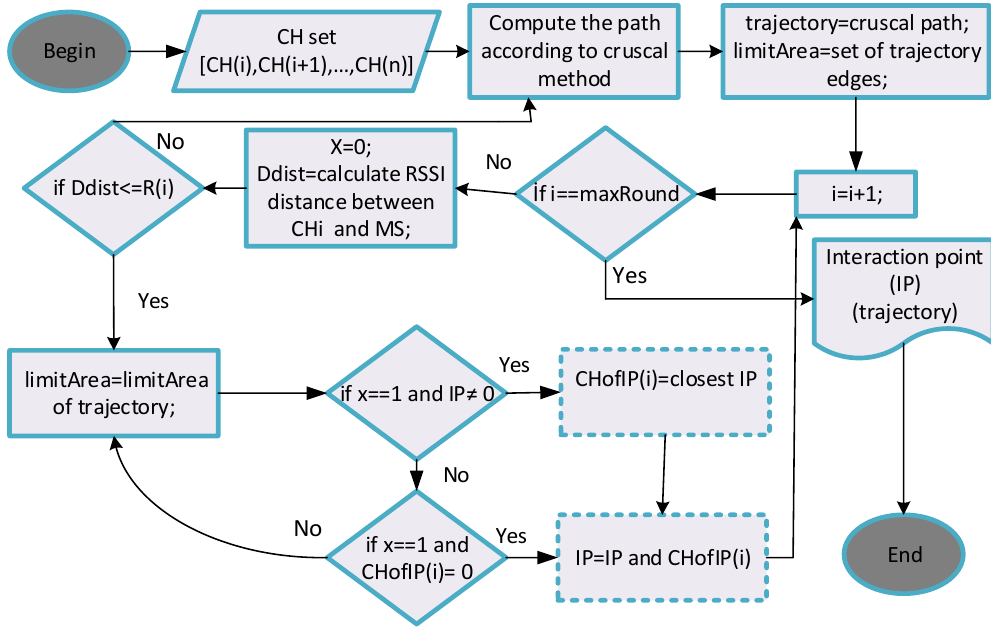
Figure 9. A flowchart of MS trajectory discovery.